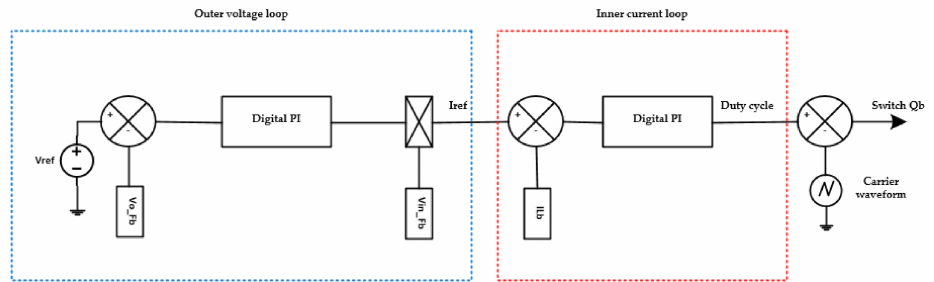
Figure 6. Implementation technique of the controlling circuit inside the